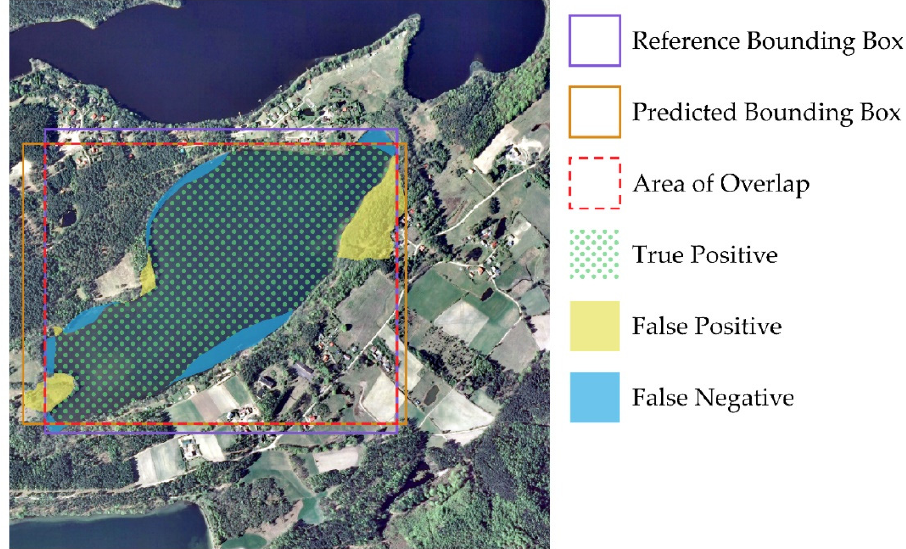
Figure 5. Example of intersection-over-union (IoU) from the LandCover.ai dataset [28]. Box-based IoU is shown using the series of rectangles. The equivalent pixel-based IoU is illustrated with the stippled texture as well as blue and yellow colors.